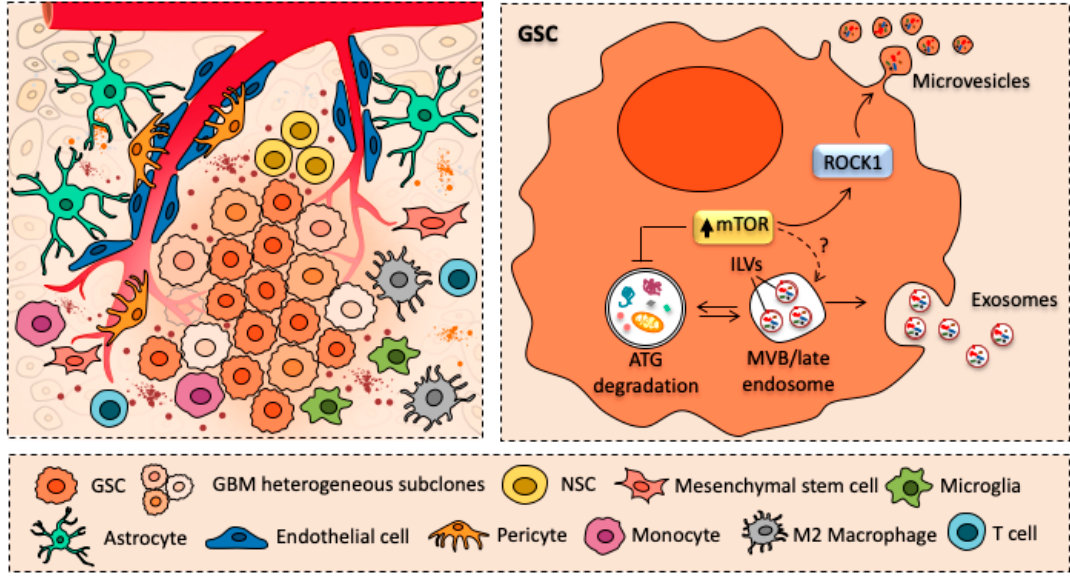
Figure 1. Glioblastoma-derived extracellular vesicles as mediators of intercellular communication. Cartoon schematizing the crosstalk between glioblastoma cancer stem cells (GSCs) and major cellular components of glioblastoma (GBM) tumor microenvironment (TME) surrounding GBM stem cell niche. In detail, GSCs can establish a dynamic and continuous interaction with resident (endothelial cells, pericytes, astrocytes) and infiltrating cells (macrophages, T cells) of TME by releasing extracellular vesicles (EVs), such as microvesicles and exosomes. Remarkably, the abundant release of EVs is tightly intermingled with mammalian Target of Rapamycin (mTOR) hyper-activation and subsequent autophagy suppression, which are key in promoting GSC self-renewal and proliferation.